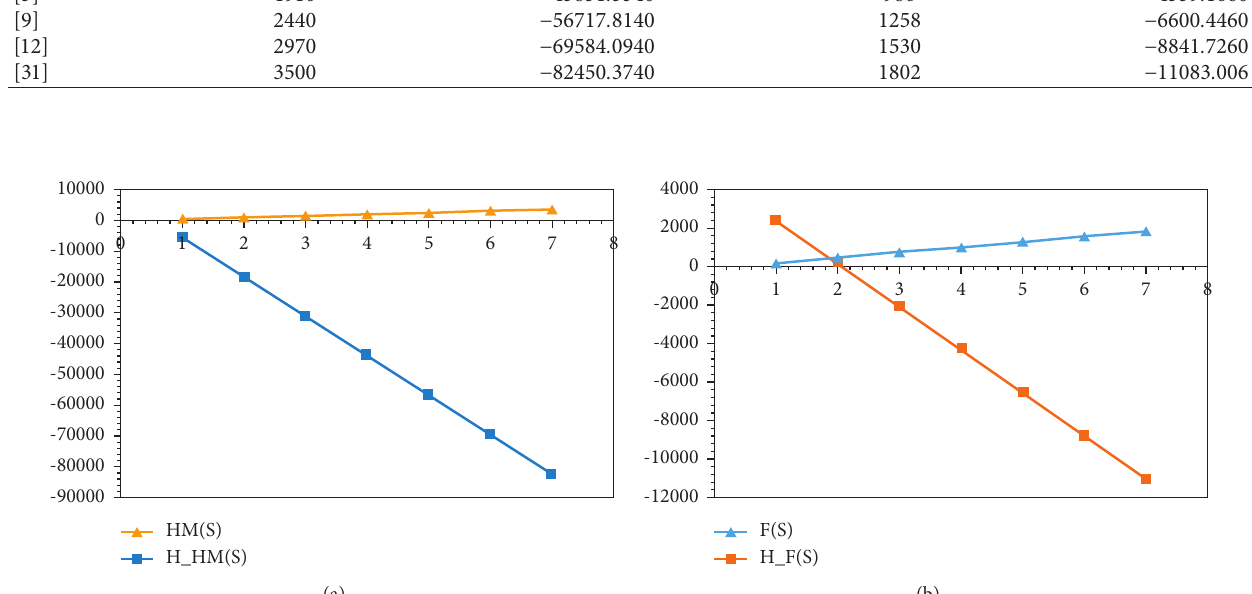
Figure 7: (a) The hyper Zagreb index with heat of formation. (b) The forgotten index with heat of formation.